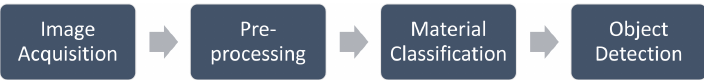
Figure 2. Primary proposed detection pipeline.